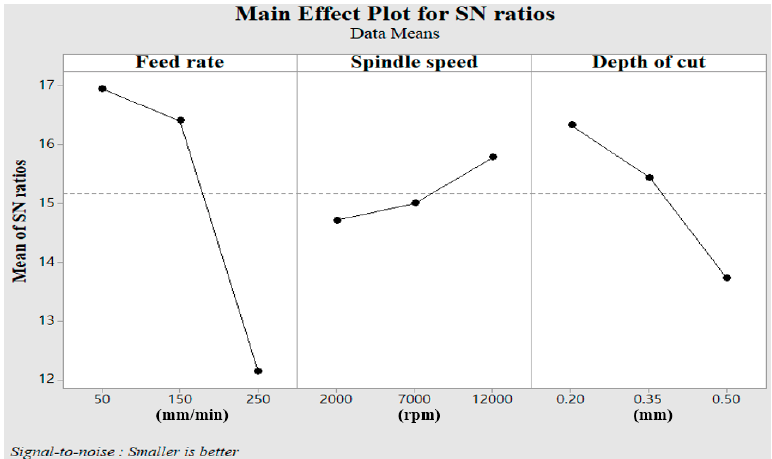
Figure 9. Main e ff ect of the S / N ratio on surface Figure 9. Main effect of the S/N ratio on surface roughness. Table 4. 𝐿 (cid:2877) (3 (cid:2872) ) Experimental results of the cutting force and surface roughness. Exp.